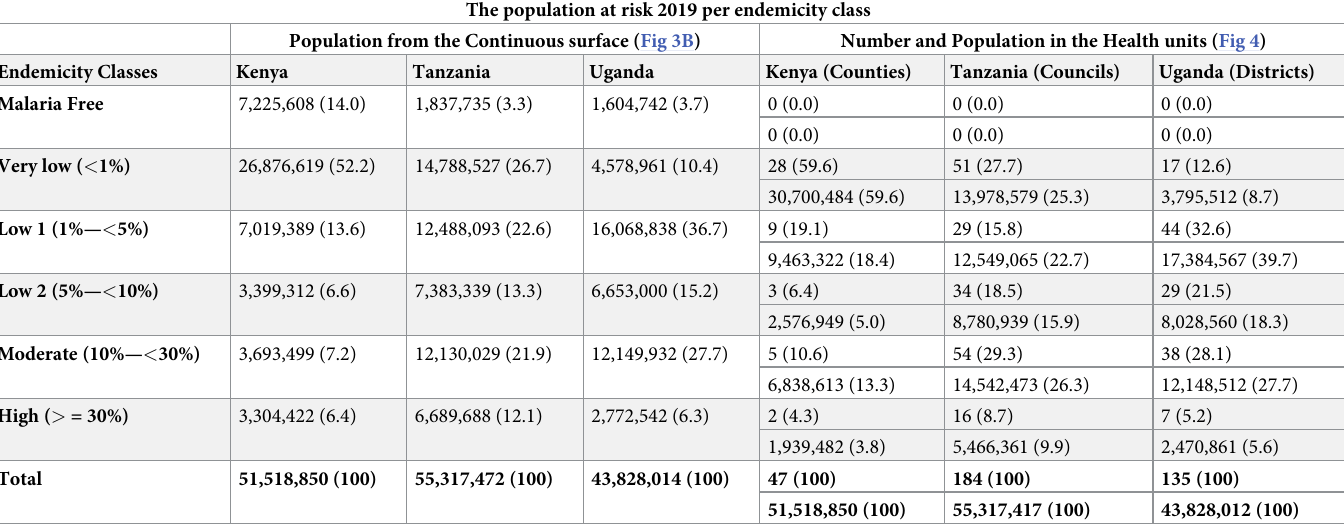
Table 1. The estimated population at risk (percentage) for all-ages in each malaria endemicity class in 2019. The population at risk 2019 per endemicity class Population from the Continuous surface (Fig